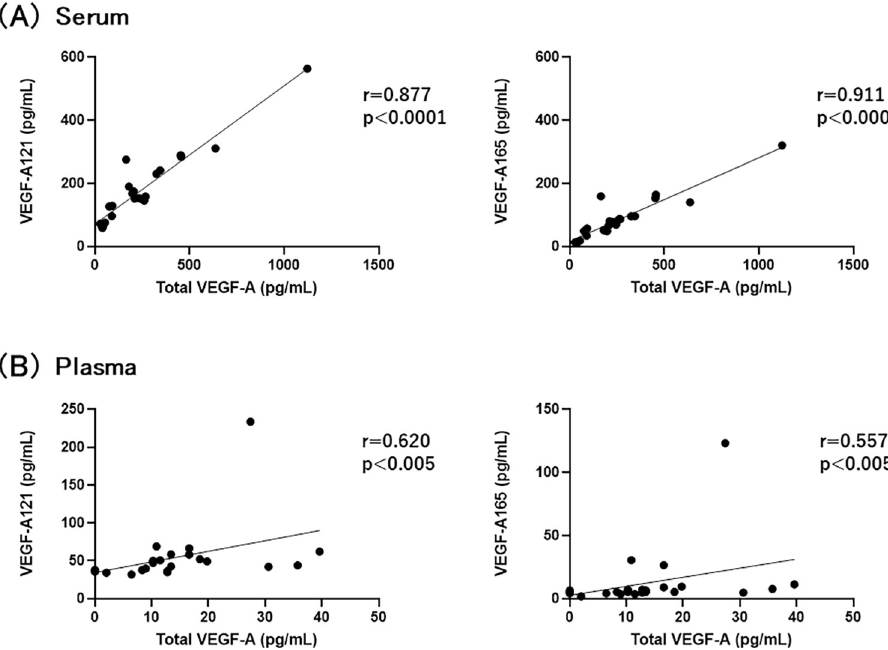
Fig 5. Levels of VEGF-A121 and VEGF-A165 were positively associated with total VEGF-A in human serum and plasma. Concentrations of total VEGF-A, VEGF-A121, and VEGF-A165 were measured in serum and plasma from healthy volunteers (n = 20). Correlation between total VEGF-A and VEGF-A121 or VEGF-A165 in serum (A) and plasma (B) were evaluated by a linear regression analysis (left panels of A and B: total VEGF-A vs. VEGF-A121, right panels of A and B: total VEGF-A vs. VEGF-A165). Correlations were determined using Spearman’s correlation test (two-tailed). Results are represented as significant at p <